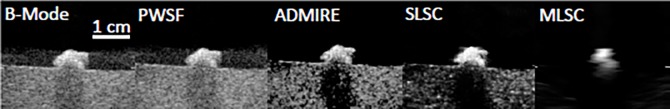
B-mode, PWSF, SLSC, MLSC, and ADMIRE images of a 10mm stone at 8cm depth.Note the posterior shadow appears below each of the stones.